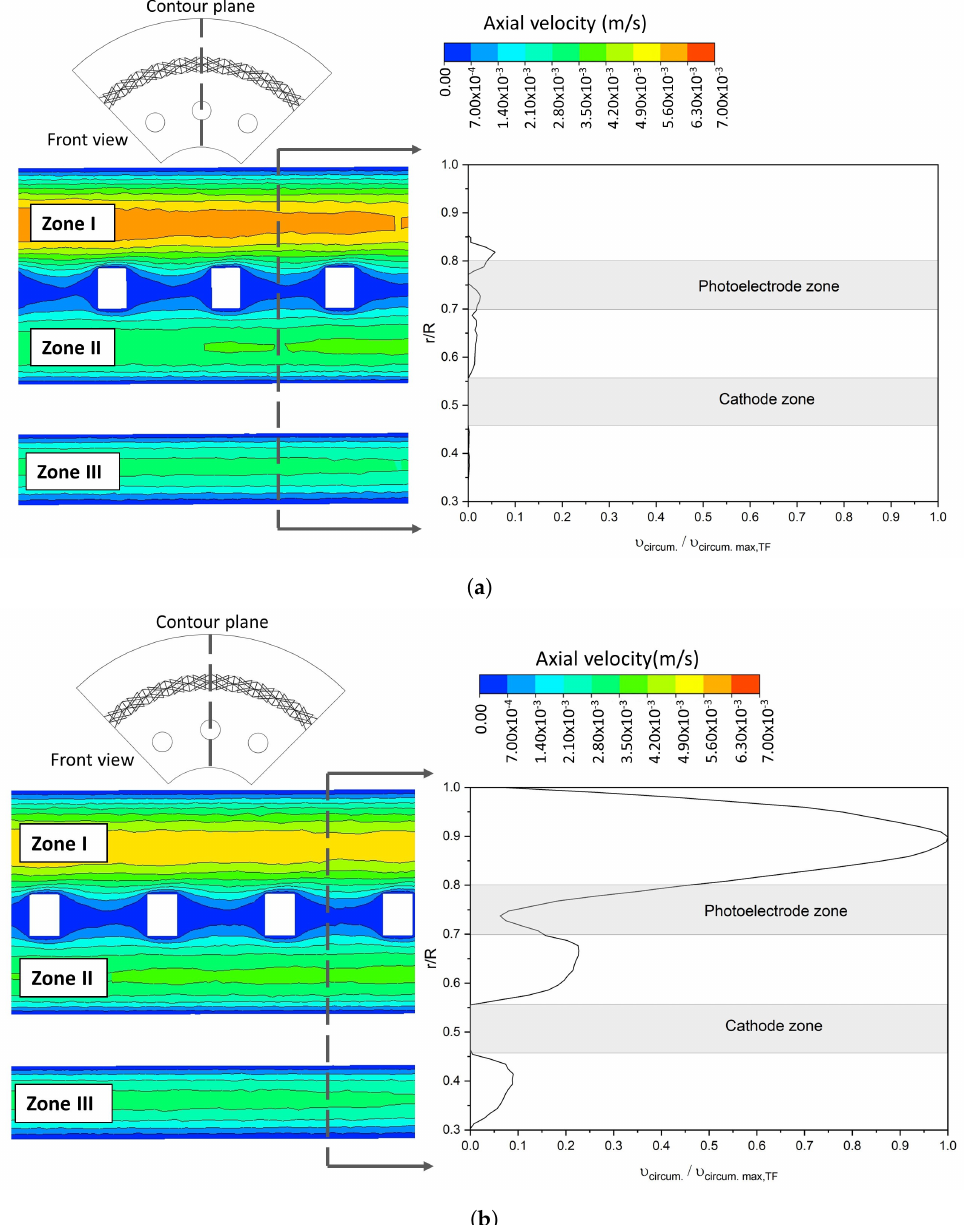
Figure 11. Axial velocity contour along axial axis and circumferential velocity profile at constant ψ (0.75 cm) and inlet velocity of 0.03 m/s for ( a ) AF and ( b ) TF configuration in laminar